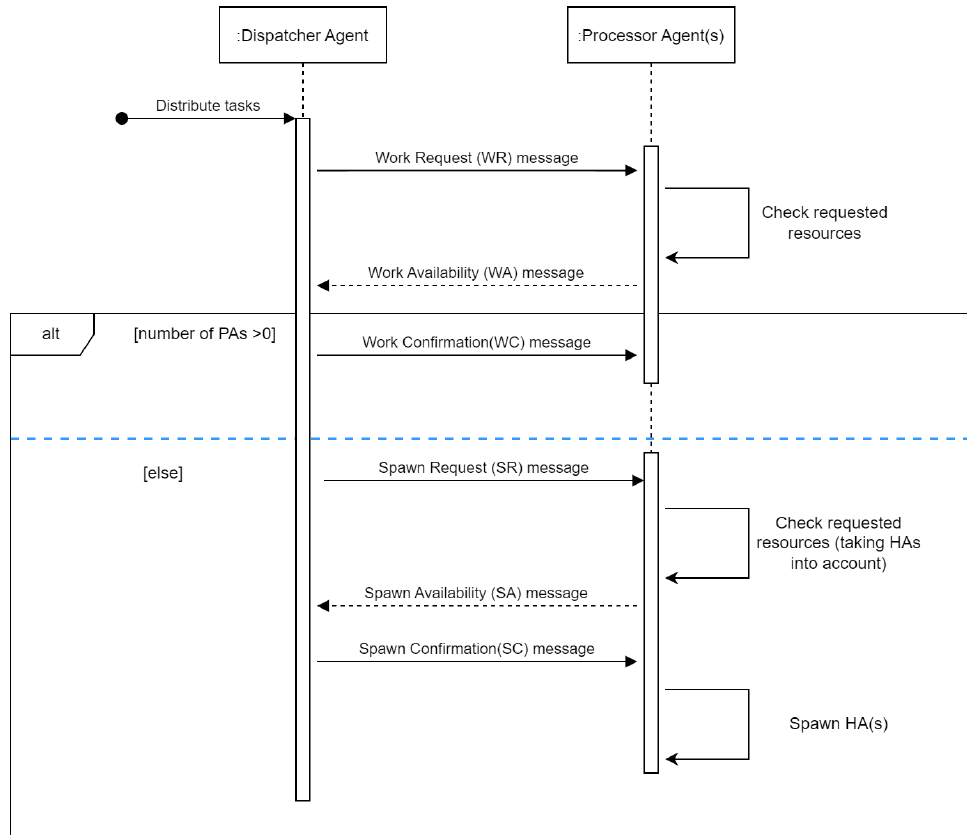
Figure 3. Communication diagram of dispatcher and processor